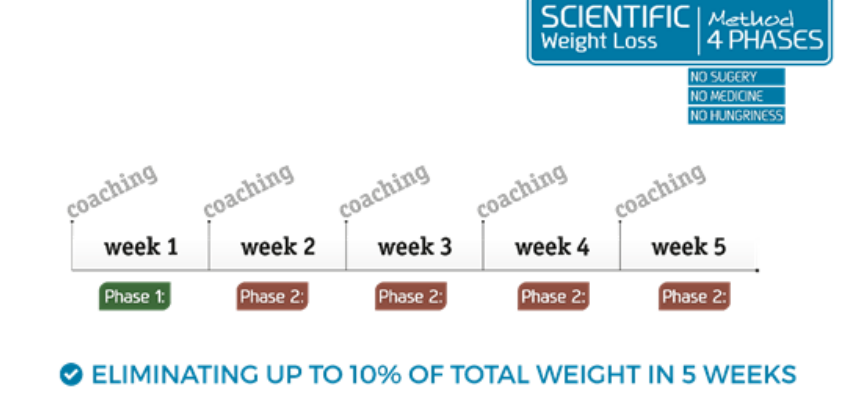
Figure 1. Representative design of the 4 Phases Method applied in this study.